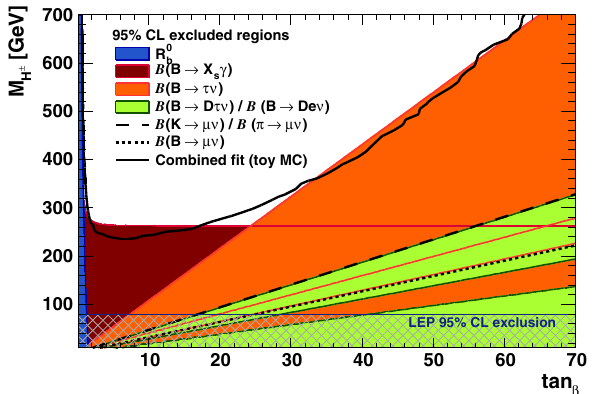
Fig. 19 ModelII95%CLexclusionregionsinthe(tan β , M H ± )plane. (Reprinted with kind permission from EPJC and the authors of